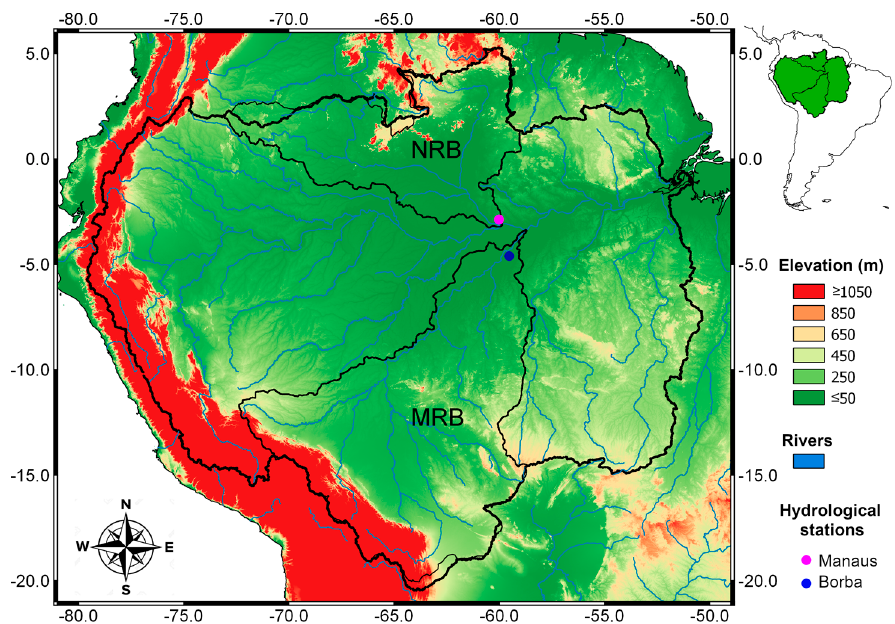
Figure 1. The black contour lines delimit the geographical locations of the Amazon River basin (ARB) and two subbasins, that is, the Negro River Basin (NRB) and Madeira River Basin (MRB) in the north and southwest of the ARB, respectively. Green and reddish colours indicate the ground elevation (m), while the blue lines represent the rivers. The pink (dark blue) circle indicates the location of the hydrological station of Manaus (Borba).